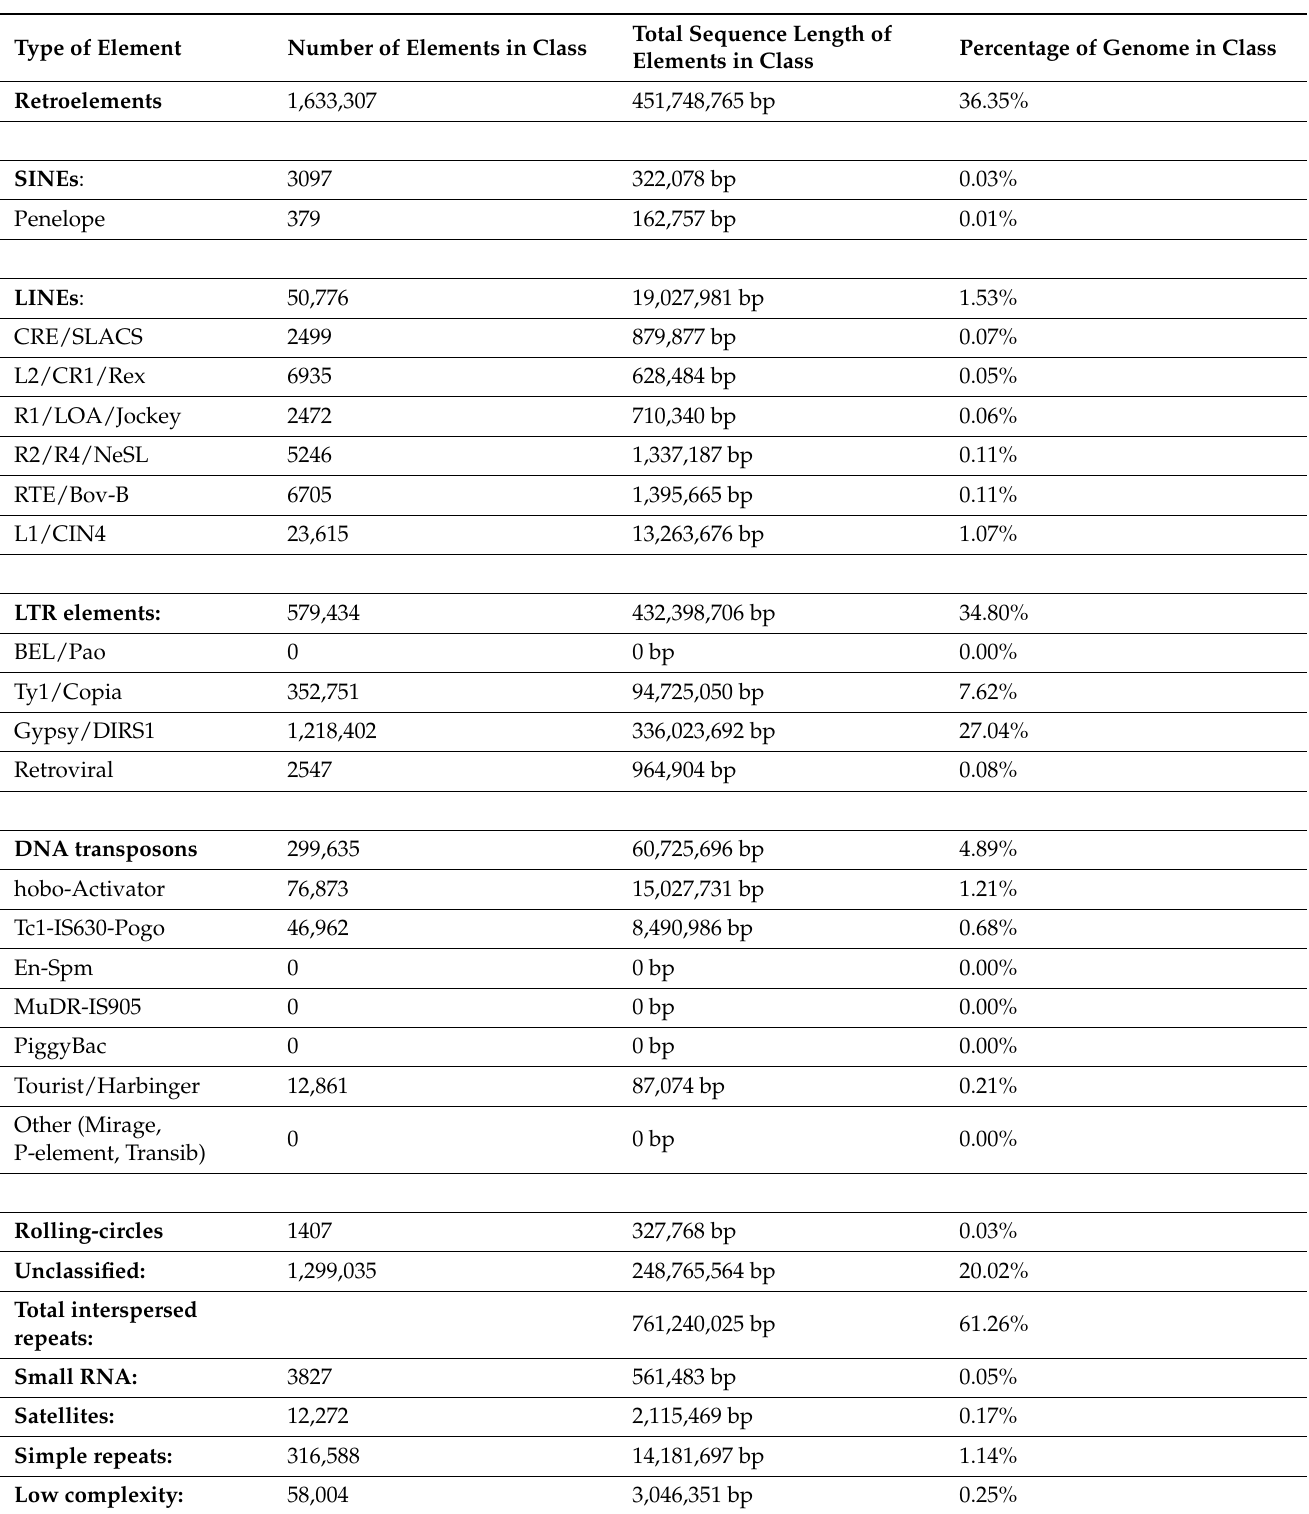
Table 3. Repetitive sequence content of Platanus k96 assembly, assessed by RepeatMasker ver- sion 4.1.1, run with rmblastn version 2.10.0+, query was compared to classified sequences in